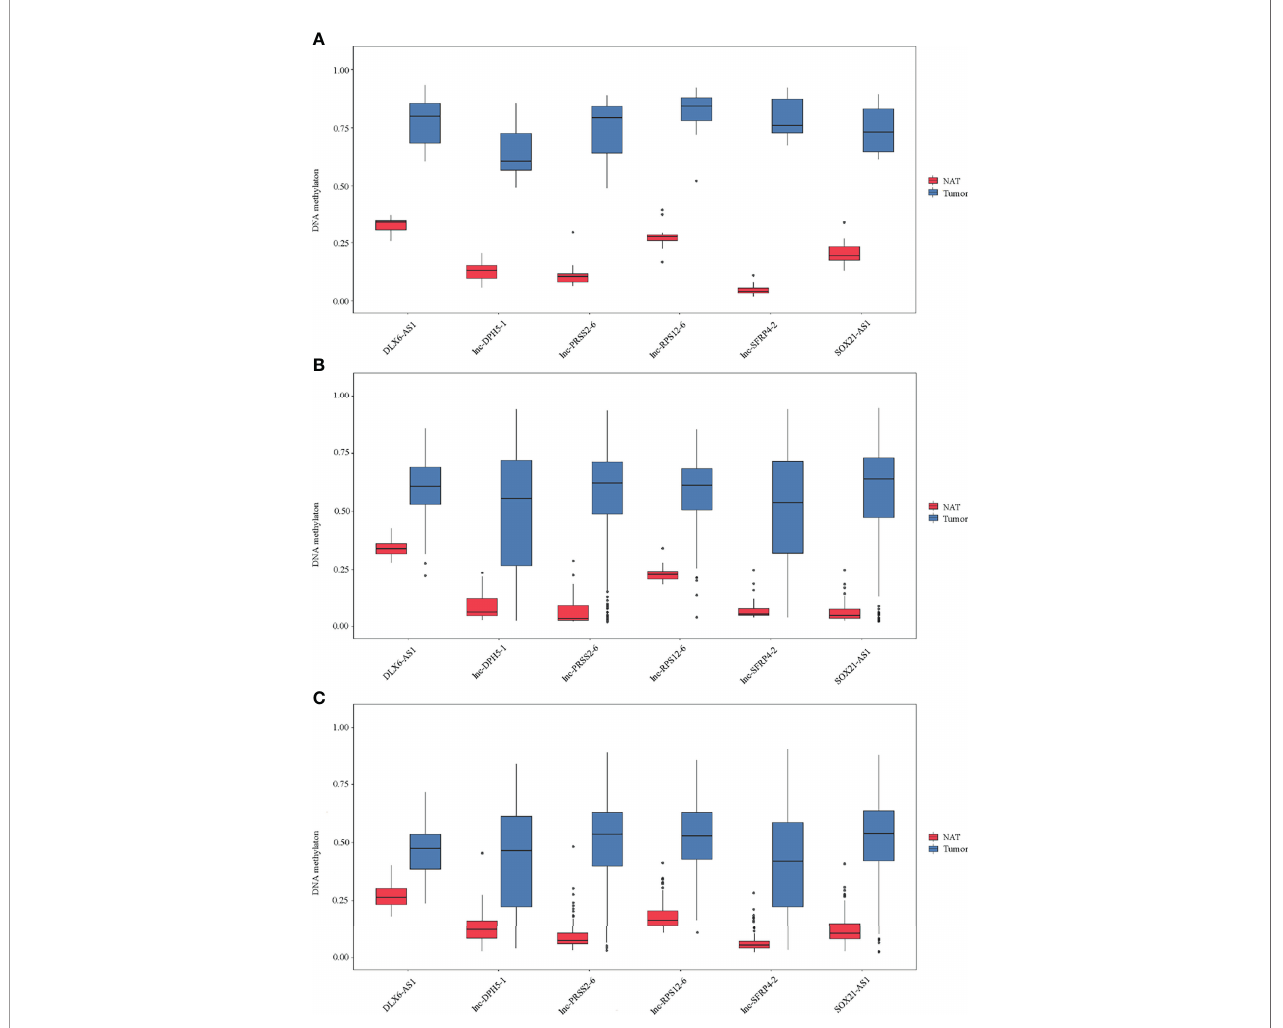
FIGURE 3 | Methylation of six selected genes in cohort I. Methylation levels of DLX6-AS1 , lnc-DPH5-1 , lnc-PRSS2-6 , lnc-RPS12-6 , lnc-SFRP4-2 and SOX21-AS1 in CRC tissues and paired normal tissues are shown for (A) 850K array of our dataset. (B) 450K array of TCGA database. (C) 450K array of GEO database. NAT, histologically normal tissue adjacent to the